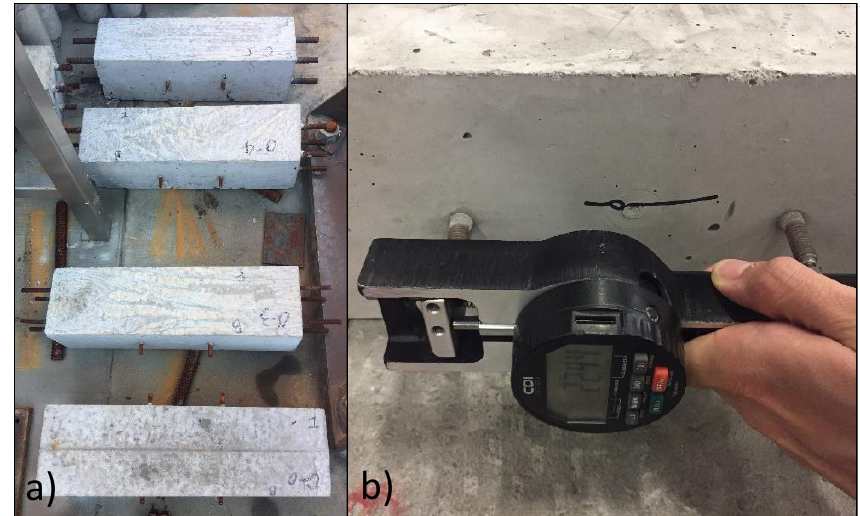
Figure 4. Expansion measurements on the prisms from NaOH-00 and NaOH-12 mixtures: ( a ) one group of prisms and ( b ) demountable mechanical (DEMEC) strain gauge device.